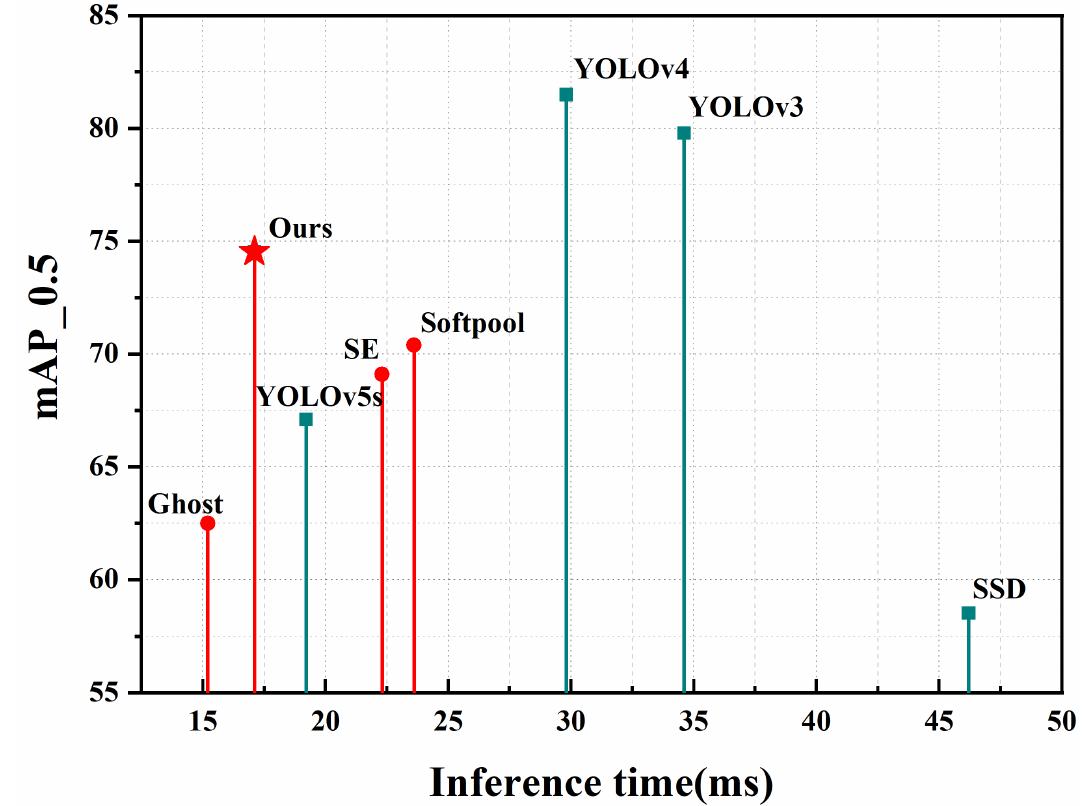
Figure 11. The AP 50 and inference time of each